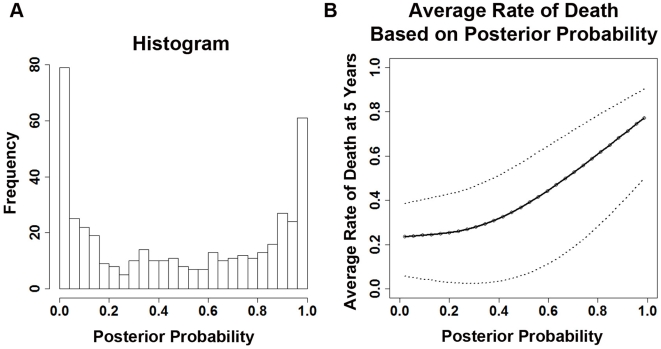
Association of the 12-gene risk score algorithm and lung cancer survival.(A). Histogram showing the distribution of the risk scores (posterior probabilities of high-risk) in 442 lung adenocarcinoma patients. (B). Average rate of death at five years after surgery corresponding to 12-gene risk score (posterior possibility). The dotted lines represent 95% confidence interval.